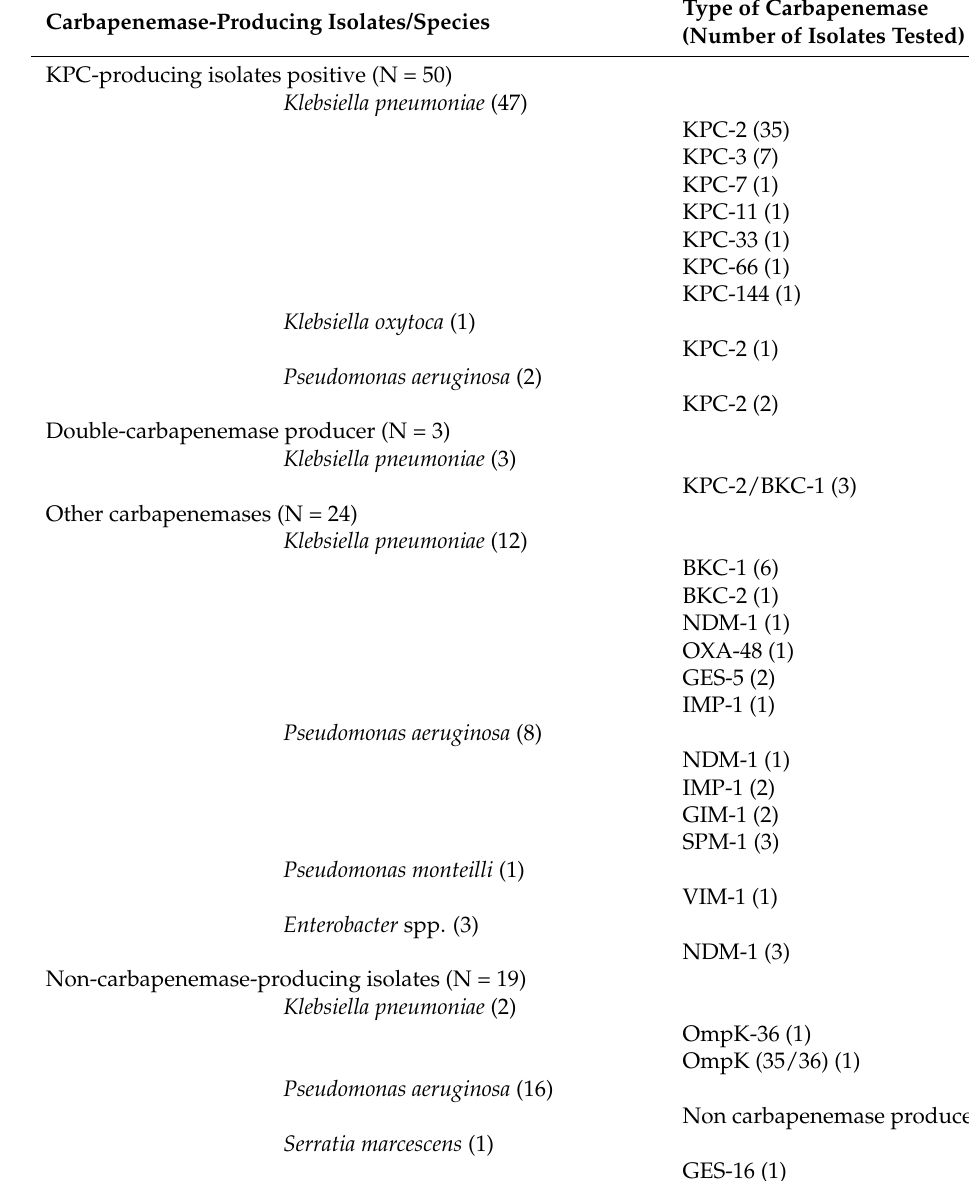
Table 2. Isolates used for ELISA-KPC test